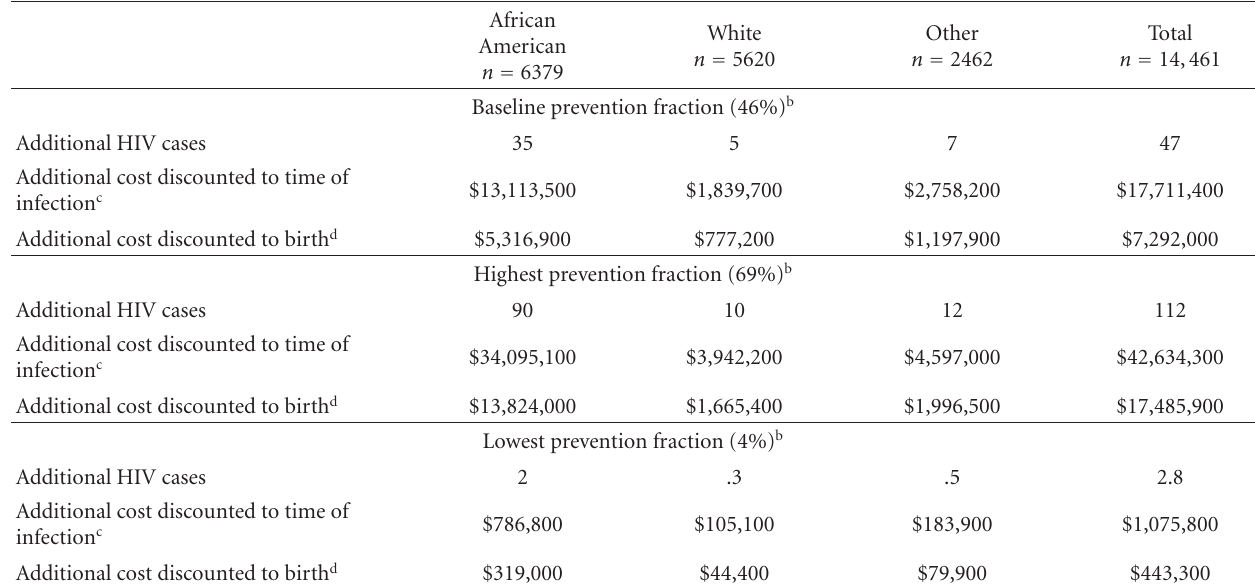
Table 5: Projected additional female cases of HIV and additional direct medical costs a .